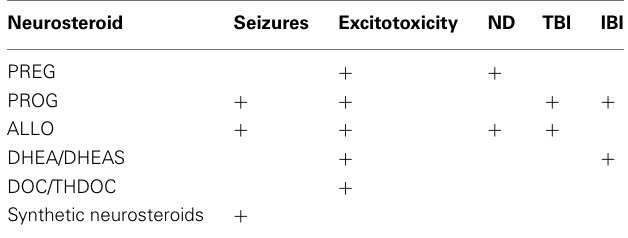
Table 1 | Leading actions of chosen